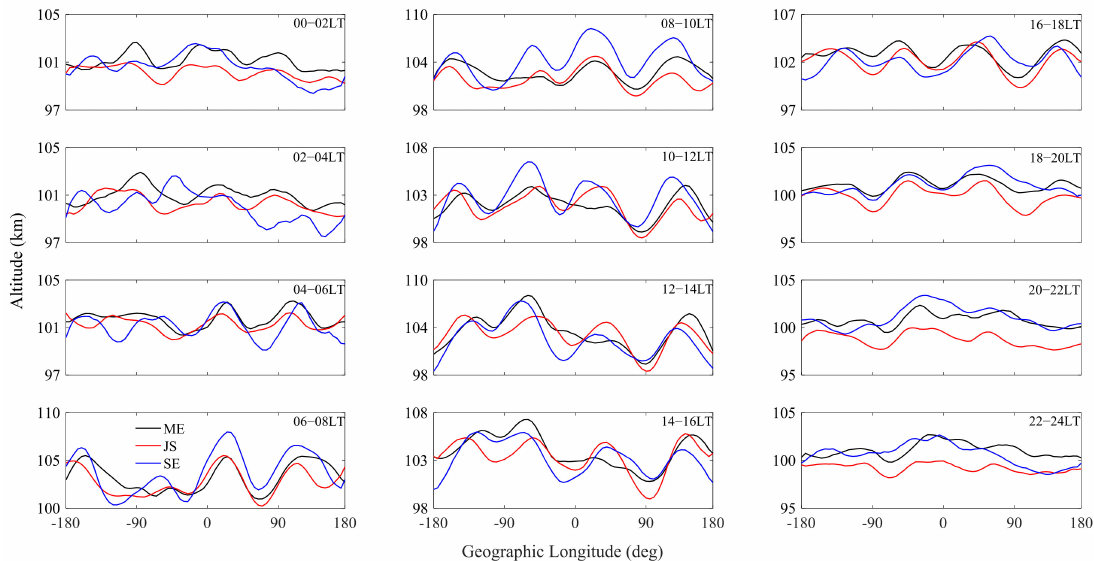
Figure 3. Longitudinal variations of the Es altitude averaged within 0–30 ◦ N at the March equinox (black lines), June solstice (red lines), and the September equinox (blue